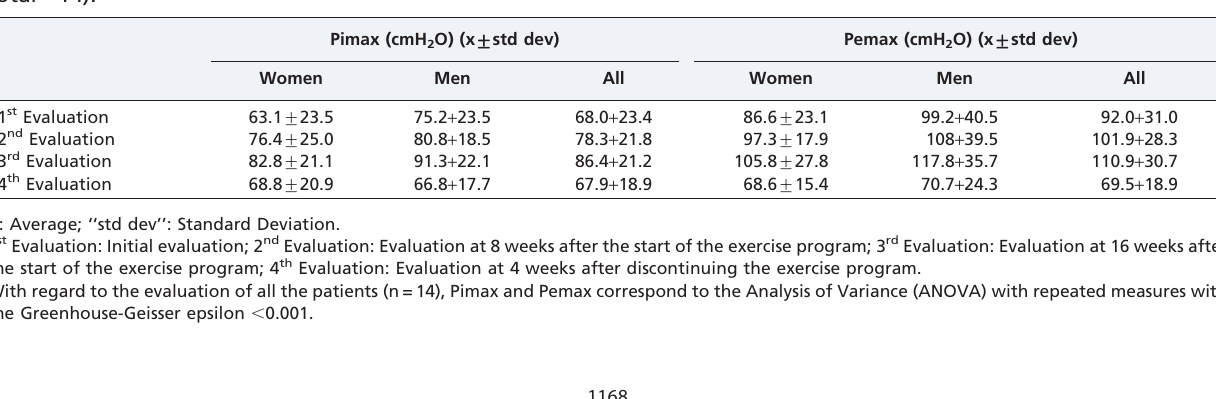
Table 2 - The measures of respiratory muscle strength assessed during the 4 patient evaluations (women = 8, men = 6, total =